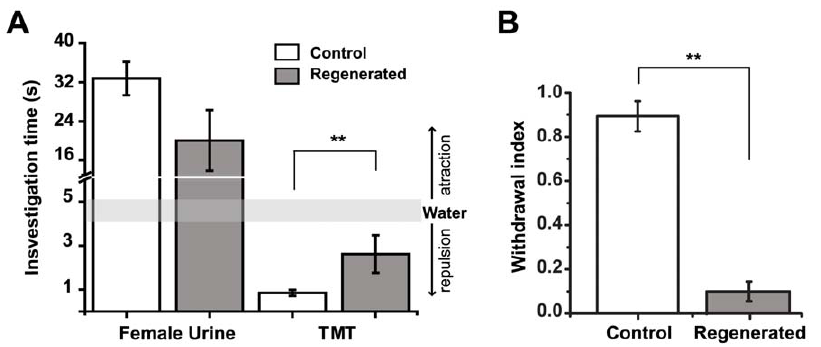
Figure 7. Odorant-clued innate behavior is partially recovered after regeneration. A , Histogram shows the investigation time for female urine and TMT. Behavioral responses to attractive female urine from regenerated males cannot be distinguished from control animals 45 days after OE ablation ( P . 0.05). However, responses to the repulsive odorant TMT are significantly different between control and regenerated animals. The latter showing significant increases in investigation time of TMT-scented filter paper and B , decreased withdrawal responses to this pheromone 45 days after ablation. (** denotes P , 0.01). Mean 6 SEM are represented.